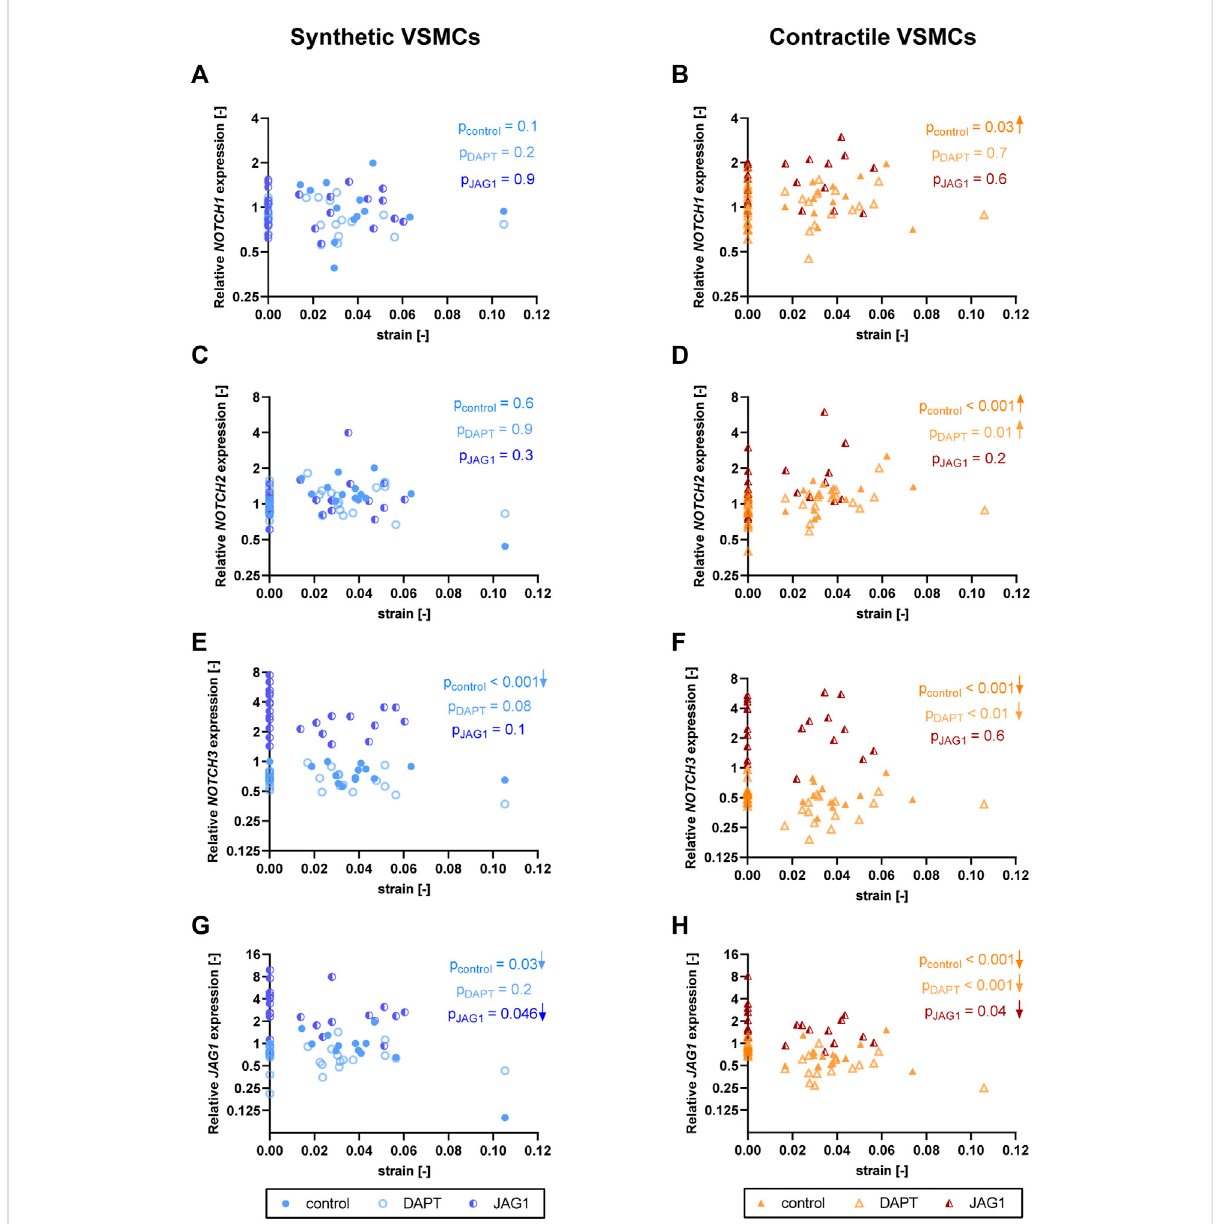
FIGURE 9 The impact of Notch signal inhibition and activation on strain-mediated changes in Notch pathway genes. Gene expression of Notch signaling components (A,B) NOTCH1 , (C,D) NOTCH2 , (E,F) NOTCH3 and (G,H) JAG1 for control, DAPT-treated and JAG1-induced (A,C,E,G) synthetic VSMCs (blue circles) and (B,D,F,H) contractile VSMCs (orange triangles) as a function of strain (normalized to static control expression). p values show the signi fi cancelevel of non-parametric Spearman correlation coef fi cient. The arrows next to signi fi cant correlations ( p < 0.05 )demonstrate an up or downregulation in gene expression with applied strain